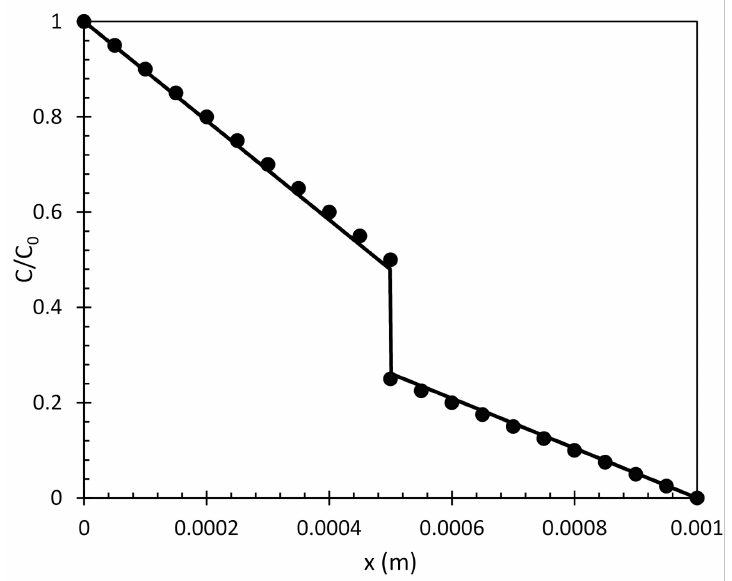
Figure A2. Steady-state concentration distribution in a 1D capillary. The line and dotes are the numerical simulation and analytical